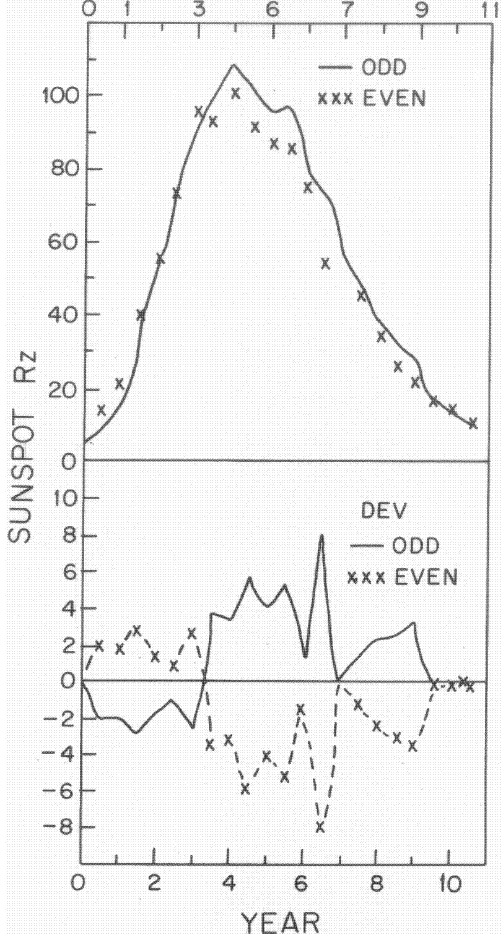
Fig. 5. Upper half, Average sunspot cycles for odd cycles 1, 3....23 (full lines) and even cycles 2, 4....22 (crosses). Lower half, devia- tions of odd and even cycles from the general average of cycles 1, 2, 3....23.